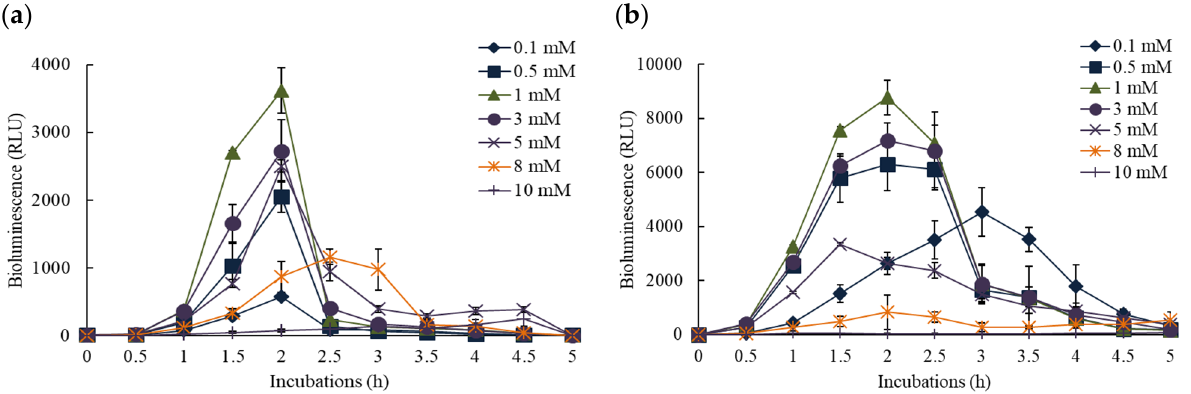
Figure 2. The time course of bioluminescence activity with different initial concentration of o -CT. ( a ) KG1206 0.1 mM-5 mM; ( b) RB1401 0.1 mM-10mM.